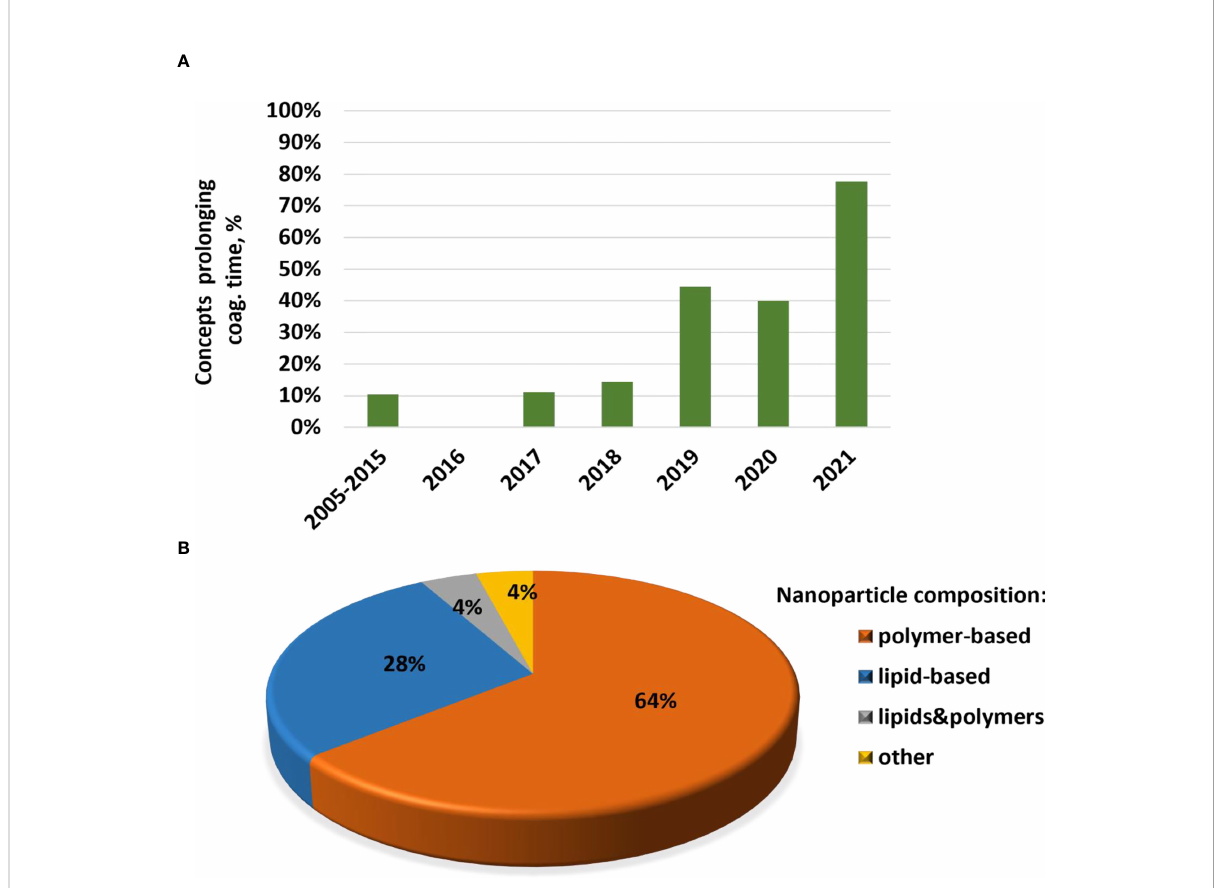
FIGURE 5 NCL assay cascade experiences with nanoparticle effects on blood coagulation. NCL has characterized more than 450 nanotechnology formulations using assay cascade protocols (https://ncl.cancer.gov/resources/assay-cascade-protocols) that include two assays for the assessment of the coagulation system (ITA-2 and ITA-12). Shown on the graph is a proportion offormulations that induced prolongation of plasma coagulation time in the NCL assay ITA-12 (A) and breakdown by nanoparticle composition offormulations resulting in APTT prolongation, a feature shared with traditional blood-thinning agent heparin (B) . Most of these concepts are polymer-based, contain lipids, or both lipids and polymers either as the core nanoparticle or excipient or both. NCL, Nanotechnology Characterization Laboratory; ITA, immunotoxicity